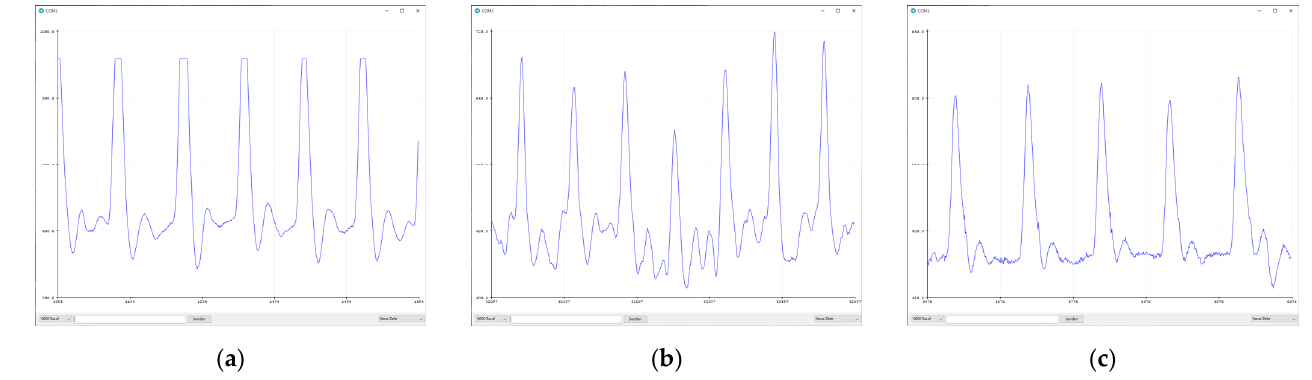
Figure 3. Pulse measurements of ( a ) proband A, left little finger (y-scale 200–1000); ( b ) proband A, left little finger, measured on the next day (400–720); ( c ) proband B, left little finger (450–650).